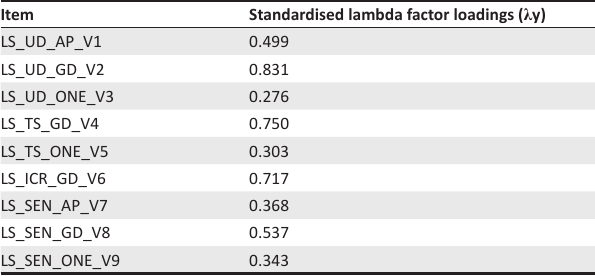
TABLE 3: Confirmatory factor analysis model parameters of 1D measurement